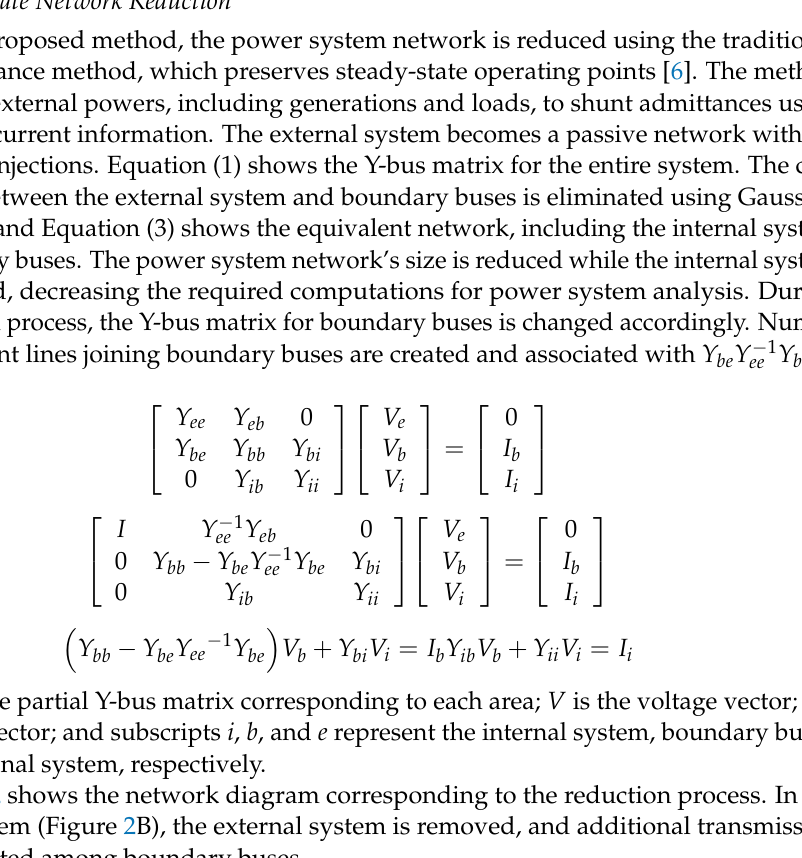
Figure 1. Procedure of the proposed